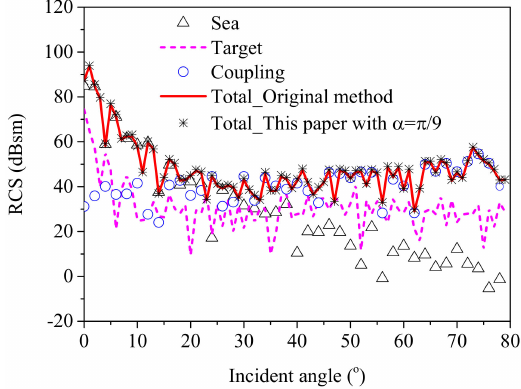
Figure 10. Comparison of di ff erent contributions in the yoz plane, d = 25 m, w = 30